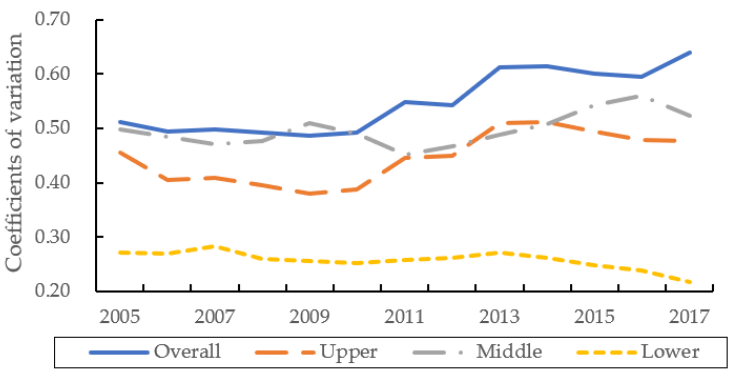
Figure 5. Evolution of the coefficient of variation of carbon emission intensity in the YRB as a whole and three regions. and three